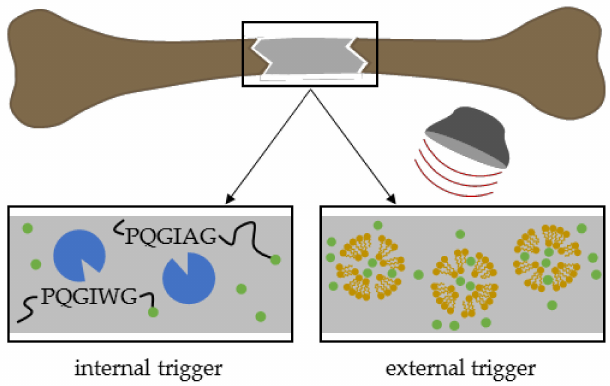
Figure 10. Exemplary targeted drug delivery approaches based on internal or external